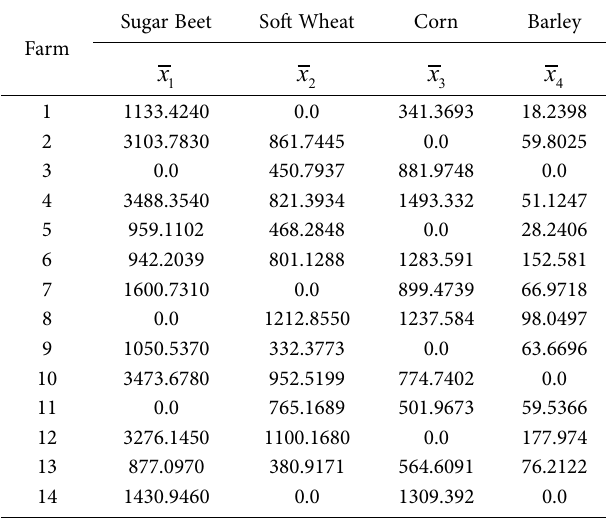
Table 7. Observed Output Levels, x with non produced